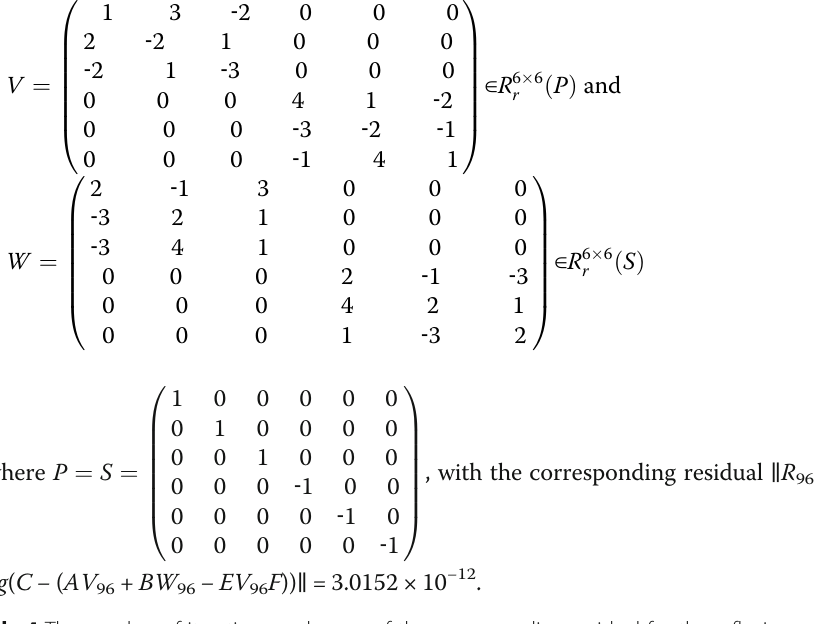
Table 4 The number of iterations and norm of the corresponding residual for the reflexive solution of the generalized Sylvester matrix equation Example